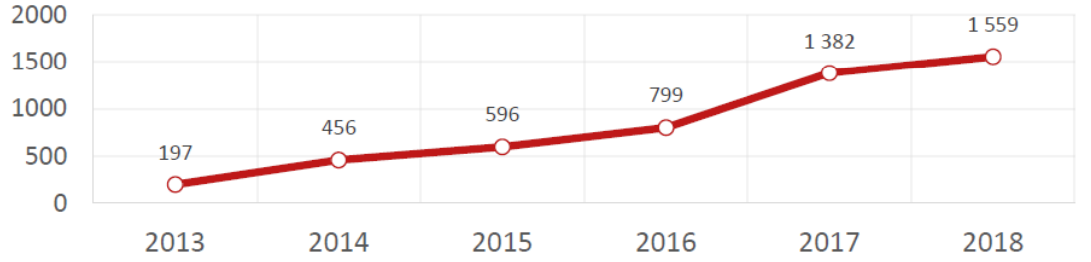
Figure 13: Gradual account growth of the retained earnings of EUROVIA CS (in millions of CZK), (source: Annual report of EUROVIA CS 2014-2018, data processed by the